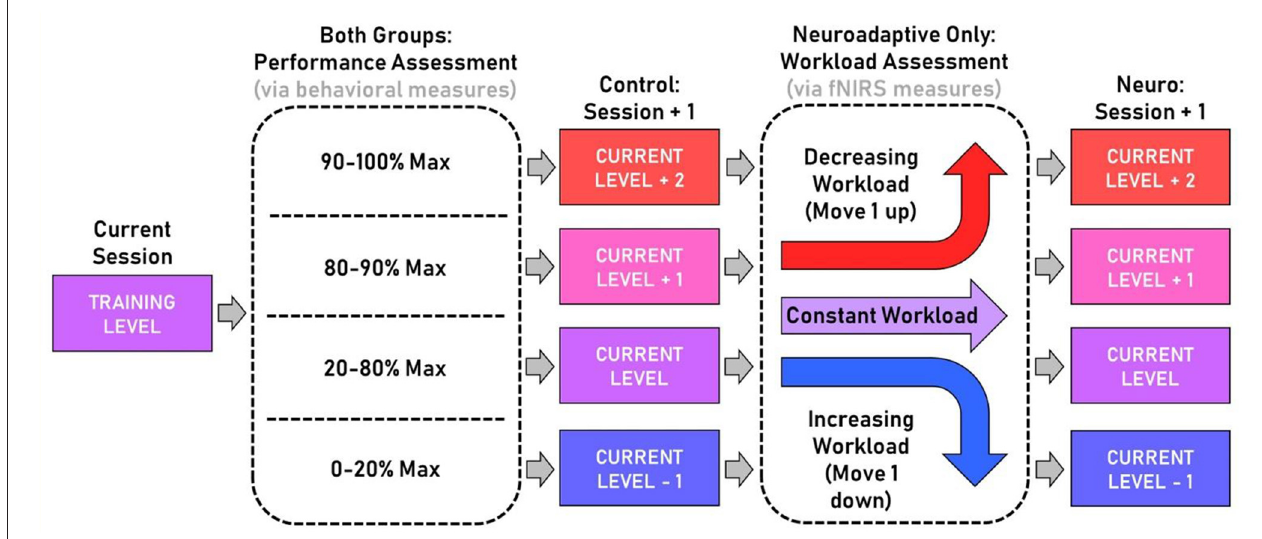
FIGURE 3 | Flowchart of the adaptive training protocol. All participants began training tasks at level 2 during the first session. Then the performance assessment was used to sort participants in both groups into four potential level changes during the next session. Only the neuroadaptive group got the workload assessment adjustment, which modified their next training level up one, down one, or not at all based on mental workload changes across the